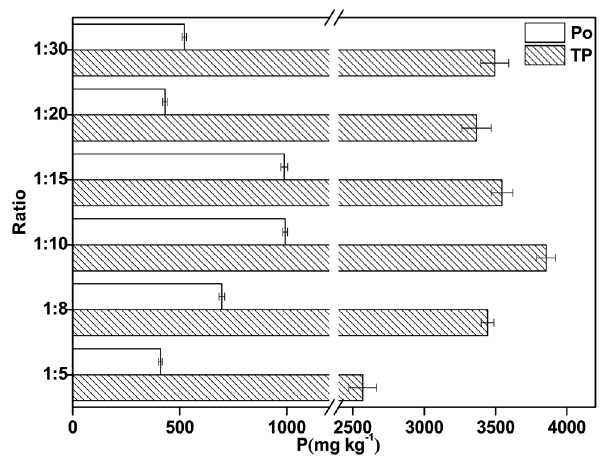
Figure 5. The total P (TP) and organic P (Po) concentrations found using different sediment:extractant solution ratios.